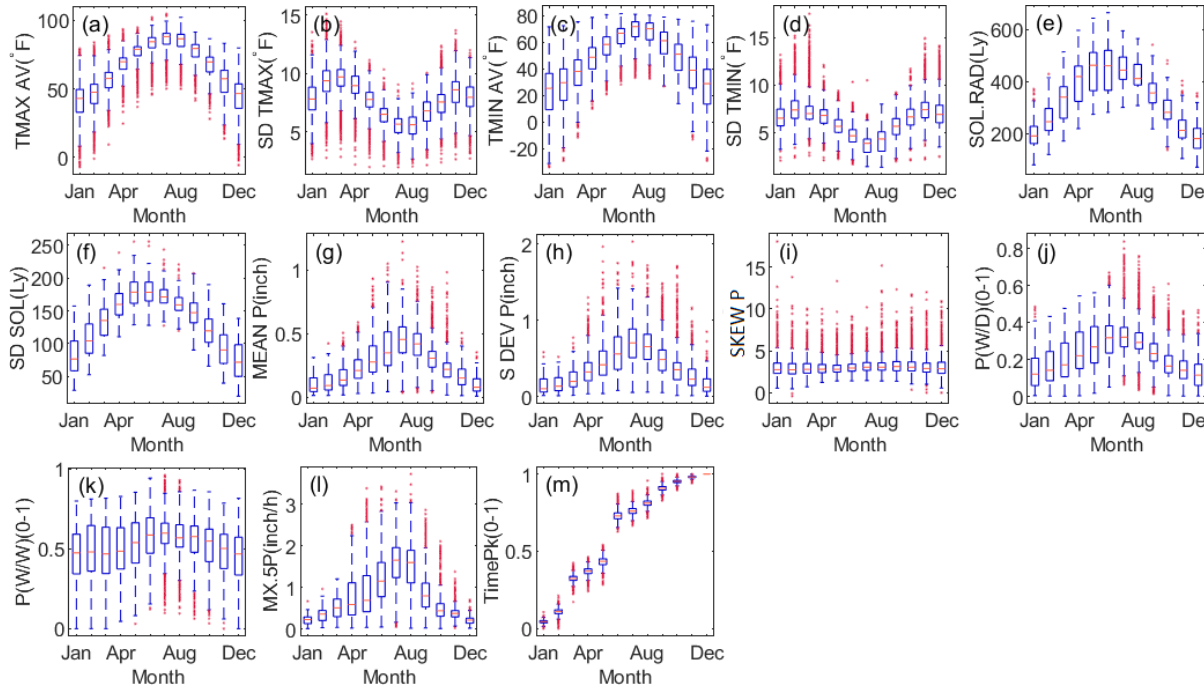
Figure 2. Boxplot of CLIGEN temperature, solar radiation, and precipitation parameters obtained from observations in mainland China.